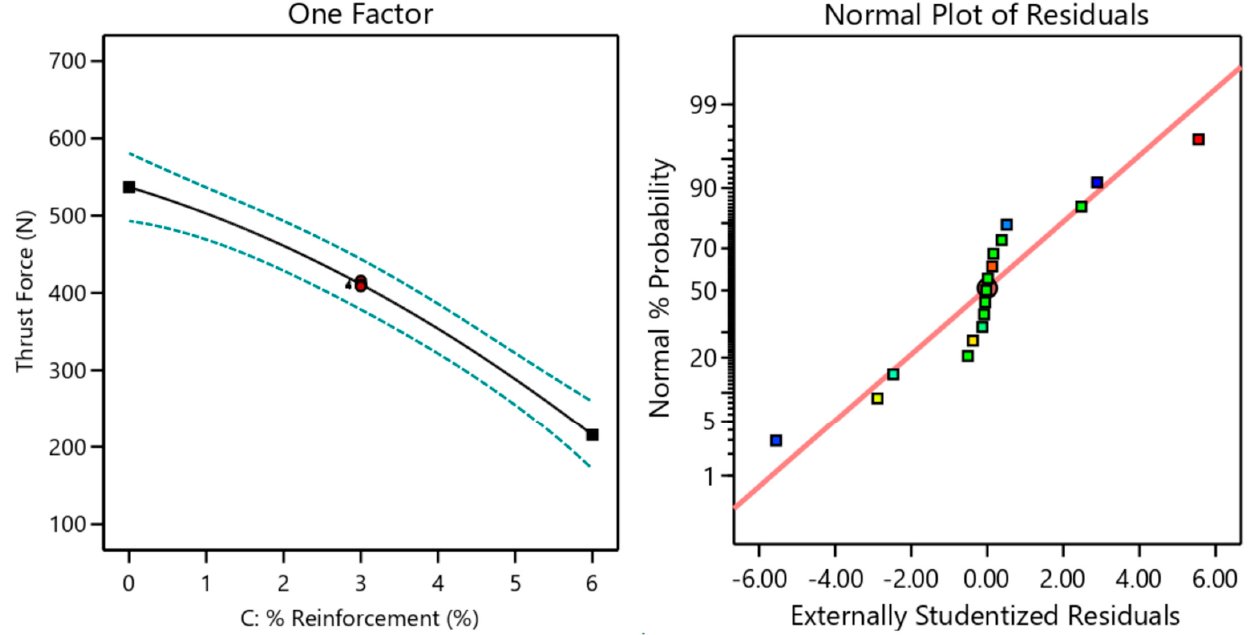
Figure 9. Effect of reinforcement on thrust force and normal probability